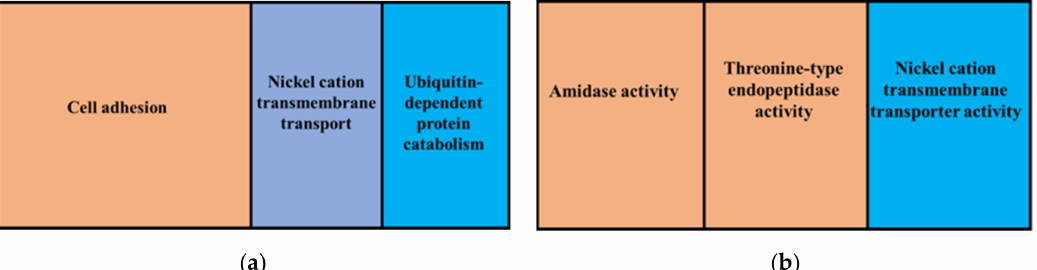
Figure 3. GO enrichment analysis for genes affected by insertions showing overrepresented GO terms, biological processes ( a ) and molecular functions ( b ). The whole genome annotations of the reference FSP34 were used as the reference set and genes affected by insertions were used as the test